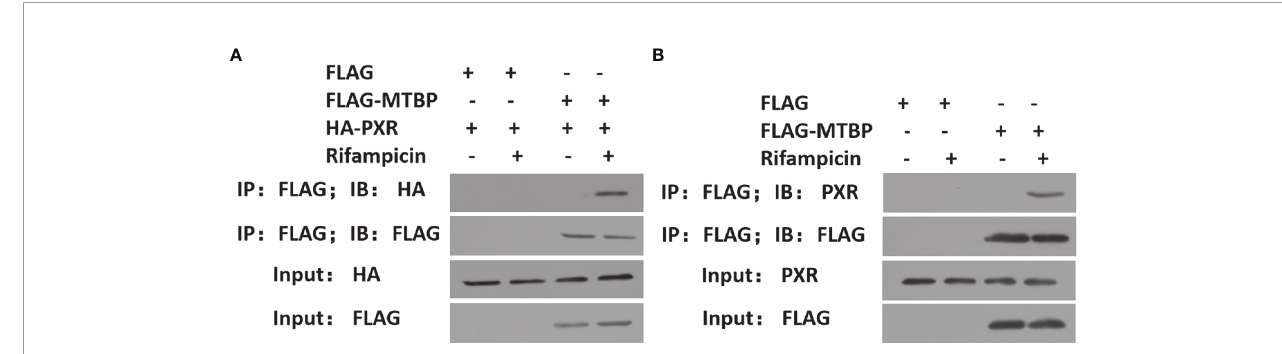
FIGURE 3 | MTBP interacted with PXR. (A) The HEK293 cells that were co-transfected with HA-PXR or FLAG-MTBP were analyzed by co-IP experiments. (B) The MHCC97-H cells which were transfected with FLAG-MTBP were analyzed by co-IP experiments.